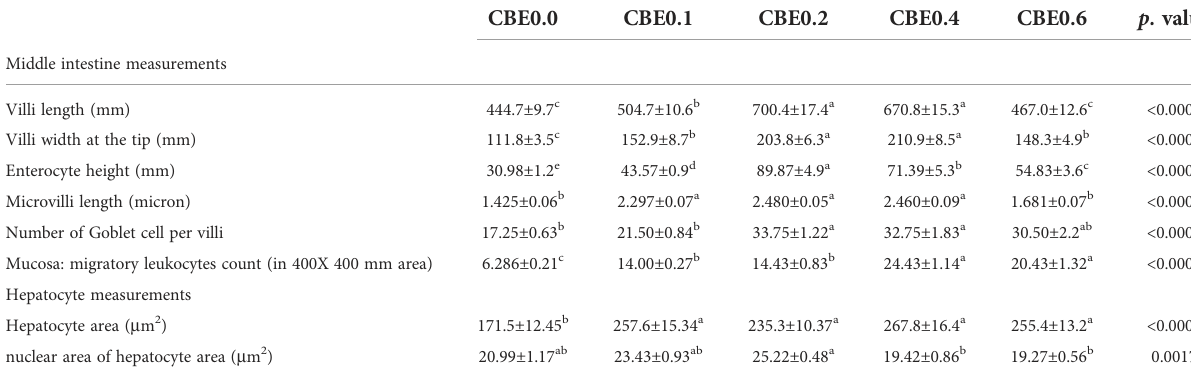
TABLE 7 Histomorphometric measurements of intestine and liver in Nile tilapia groups feed on different doses of CBE for 10 weeks.